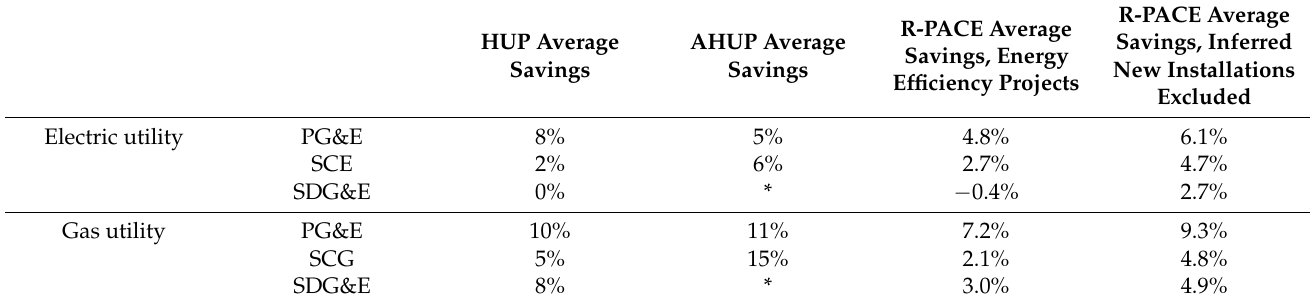
Table 5. Average electricity and gas savings of HUP, AHUP, and R-PACE projects. R-PACE Average R-PACE Average Savings, Inferred HUP Average AHUP Average Savings, Energy New Installations Savings Savings Efficiency Projects Excluded Electric utility PG&E 8% 5% 4.8%